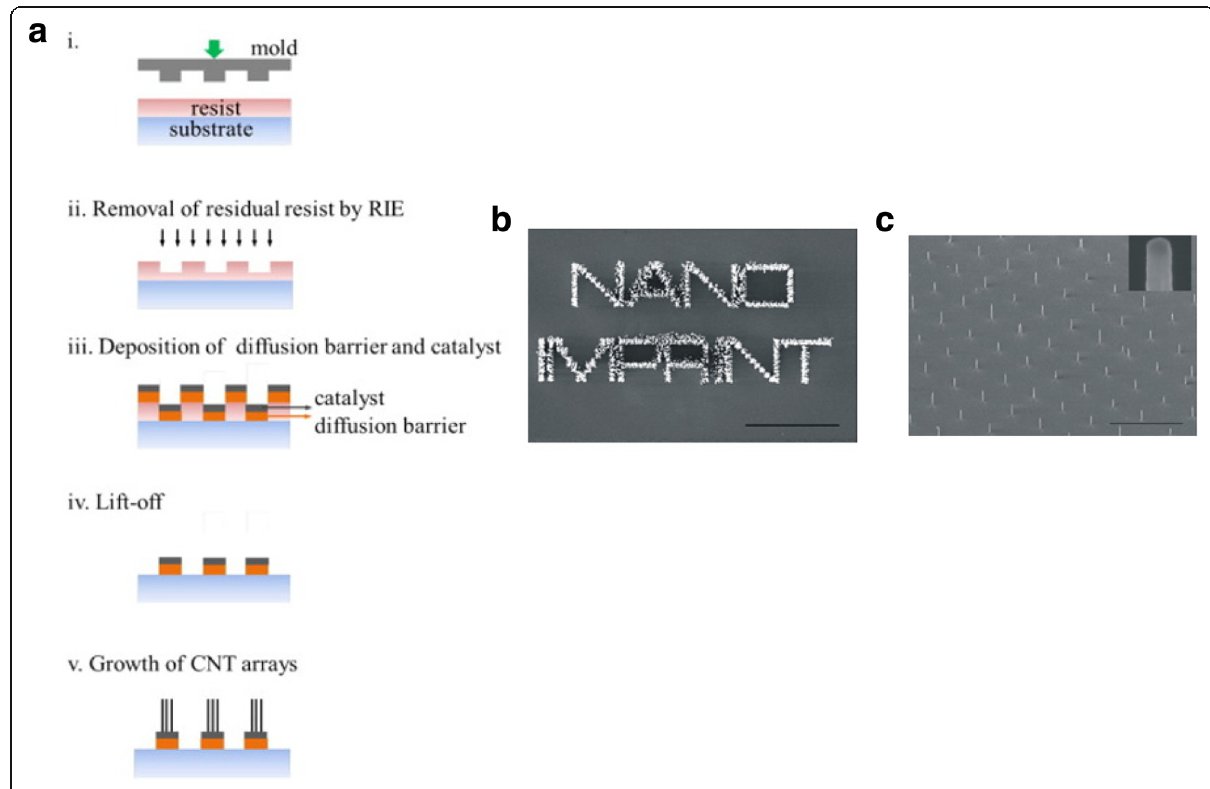
Fig. 25 a Schematic of steps involved in the growth of CNT arrays using NIL. Adapted from [193]. b , c SEM images of CNTs grown using NIL. b CNTs arranged in a word format reading ‘ Nano imprint ’ . Scale bar equals 20 μ m. Adapted from [192]. c An array of CNTs with 10 μ m spacing. Inset shows the tip of an individual MWCNT grown using Ni catalyst. Adapted from